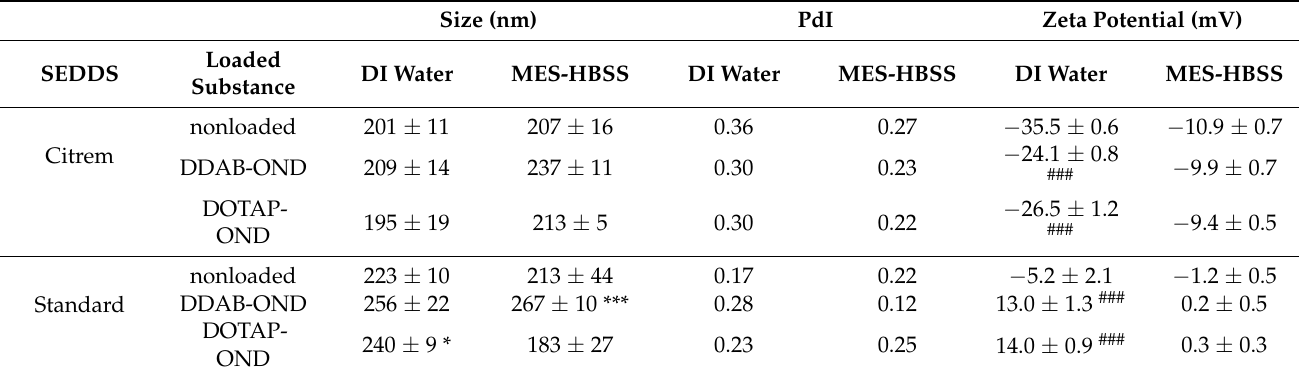
Table 6. Size and zeta potential of Citrem and Standard SEDDS. The parameters were tested in deionized (DI) water and